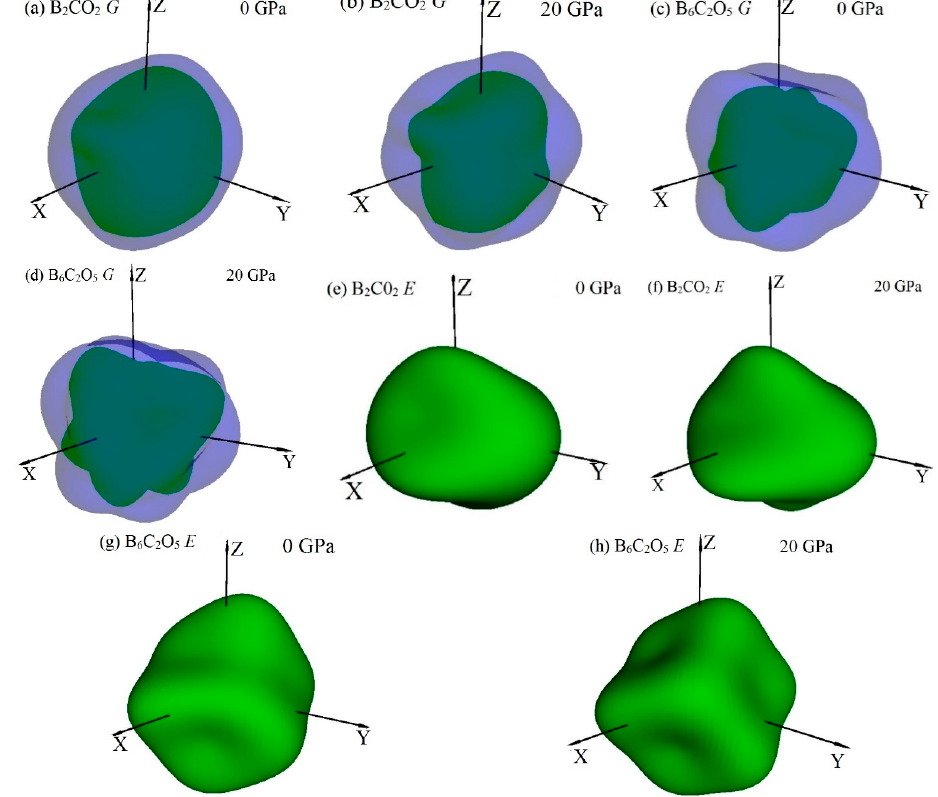
Figure 5. Directional dependence of the shear modulus at 0 GPa ( a ) and 20 GPa ( b ), and Young’s modulus at 0 GPa ( c ) and 20 GPa ( d ) of B 2 CO 2 ; and Directional dependence of the shear modulus at 0 GPa ( e ) and 20 GPa ( f ), and Young’s modulus at 0 GPa ( g ) and 20 GPa ( h ) of B 6 C 2 O 5 .